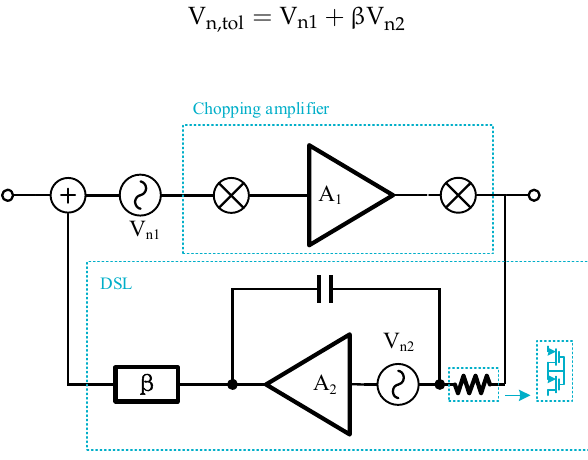
Figure 6. Behavioral level model of the DSL with attenuator.